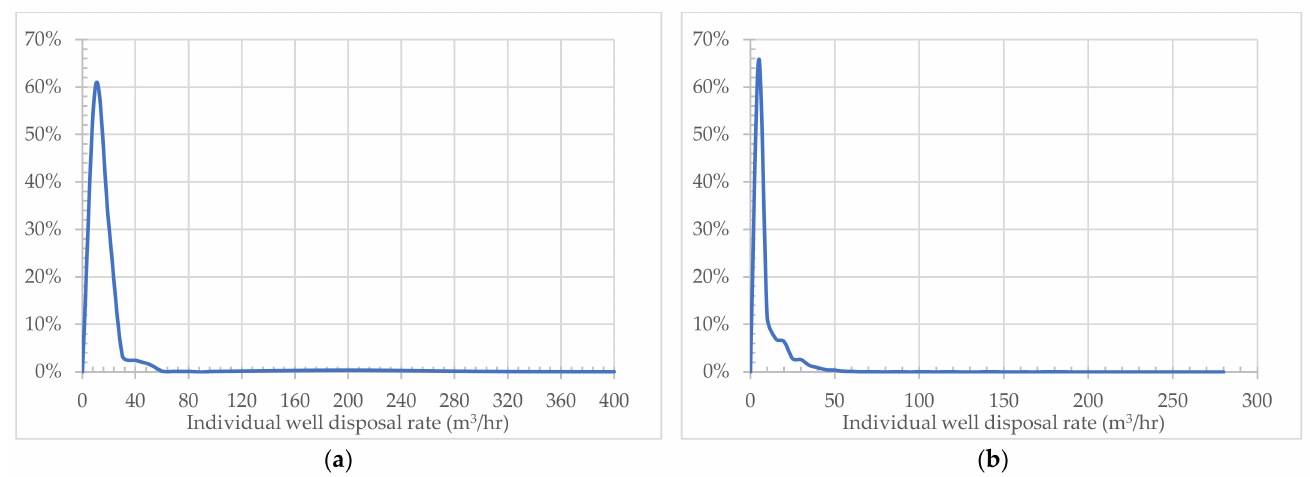
Figure A26. Historical per-well water injection rate ( X -axis) frequency ( Y -axis) distributions (January 1962–December 2022) in ( a ) the Arcs Formation; ( b ) the Grosmont Formation.